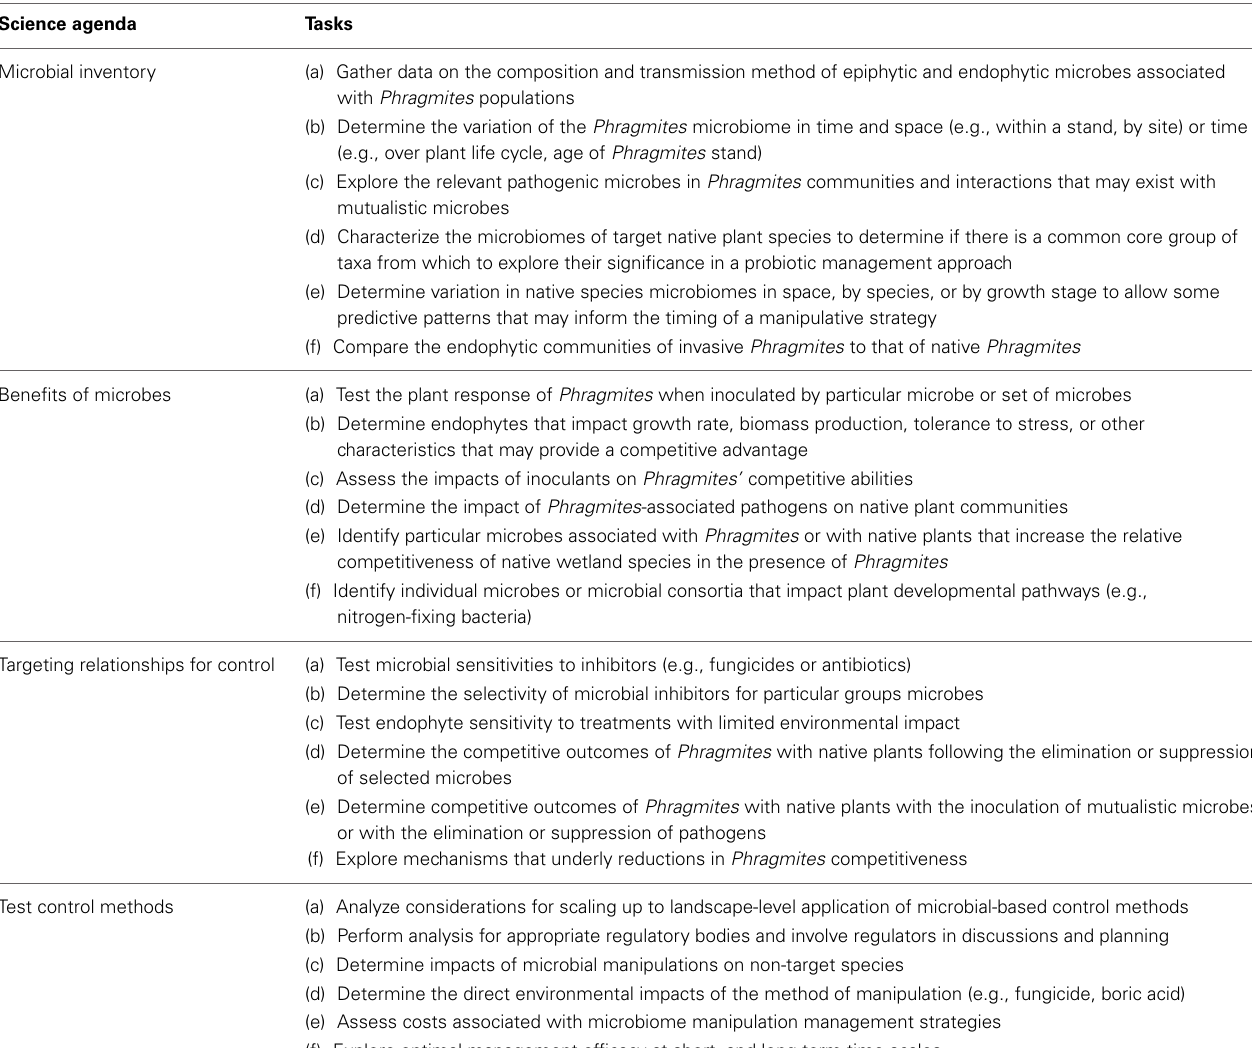
Table 1 | Specific tasks outlined by members of PSC to guide research to support Phragmites management using microbial